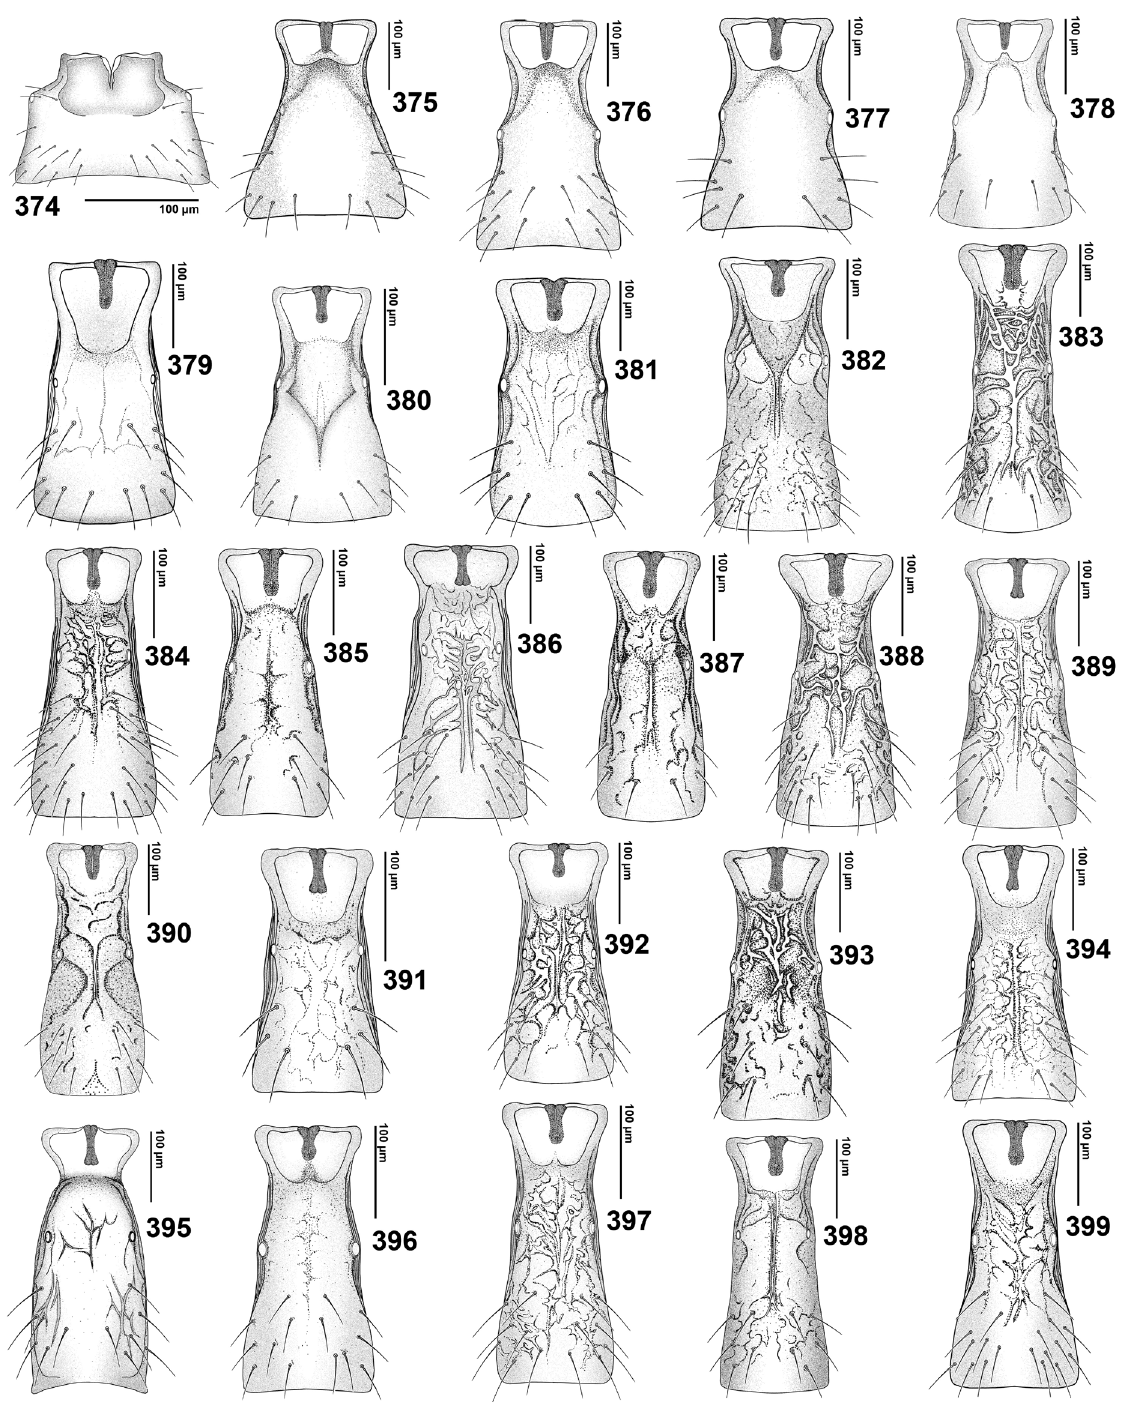
Figs 374–399. Dorsal aspect of petiole (♀): 374 . Aclitus obscuripennis . 375 . Adialytus ambiguus . 376 . Adialytus salicaphis . 377 . Adialytus thelaxis . 378 . Adialytus veronicaecola . 379 . Aphidius absinthii . 380 . Aphidius arvensis . 381 . Aphidius asteris . 382 . Aphidius avenae . 383 . Aphidius banksae . 384 . Aphidius cingulatus . 385 . Aphidius colemani . 386 . Aphidius eadyi . 387 . Aphidius eglanteriae . 388 Aphidius ervi . 389 . Aphidius funebris . 390 . Aphidius hieraciorum . 391 . Aphidius iranicus . 392 . Aphidius matricariae . 393 . Aphidius microlophii . 394 . Aphidius persicus . 395 . Aphidius platensis . 396 . Aphidius popovi